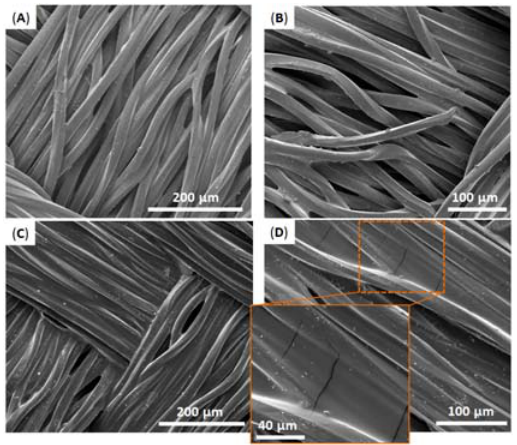
Figure 11. Scanning electron microscopy (SEM) images of fabric samples ( A , B ) before and ( C , D ) after being coated with catHMDA-16 h/amine. Inset in ( D ) shows zoom area of the coated polyester fabric fibers, where small cracks can be observed on its surface.